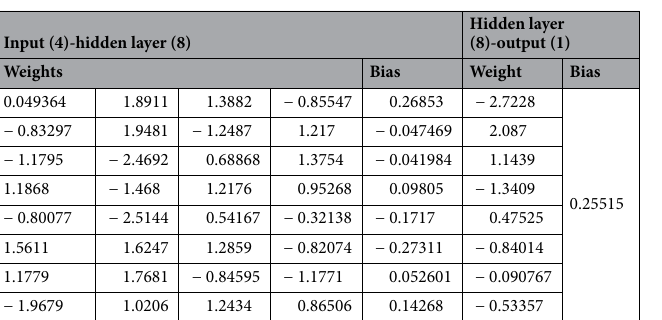
Table 6. Obtained weights and biases of the built ANN model for the RR198 adsorption by MSE compost ash.